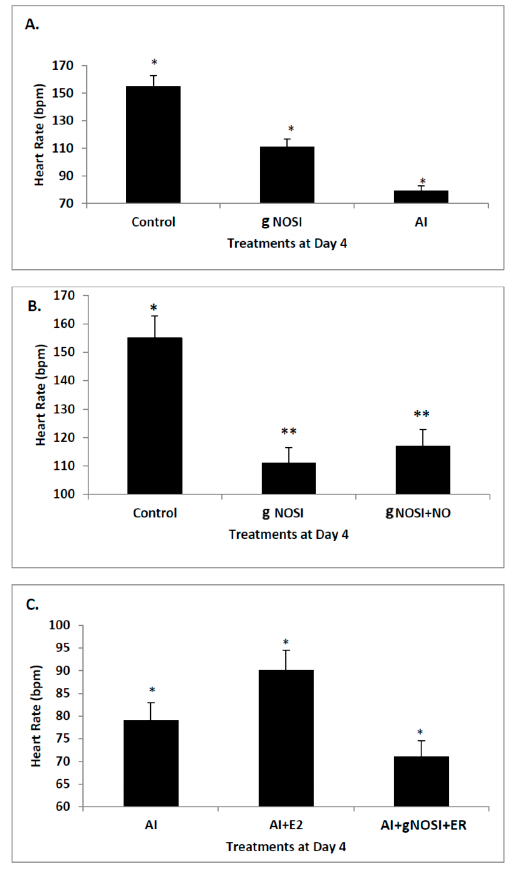
Figure 1. The effects of various treatments on fish heart rates (HR) in beats/minute (bpm) after 4 days of treatment beginning at 48 h post fertilization (hpf). ( A ) This figure indicates that both AI (50 µ M) and general (g) NOSI (15 mM) significantly reduces ( p < 0.001) HR; ( B ) These data indicate that gNOSI + NO (50 µ M) co-treatment significantly rescues (** p < 0.05) HR when compared to that of gNOSI; ( C ) On the other hand, gNOSI can prevent the rescue of HR caused by E2 (10 nM) replacement therapy. Specifically, if gNOSI is added to the AI + E2 treatment paradigm, the rescue of HR was significantly eliminated ( p < 0.001). All bars = ± SD. Asterisks indicate significant differences between treatment groups and